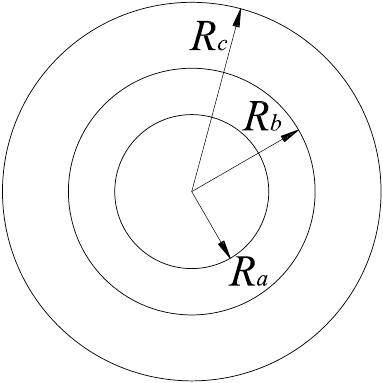
Figure 4. Connection diagram of the box and the pin